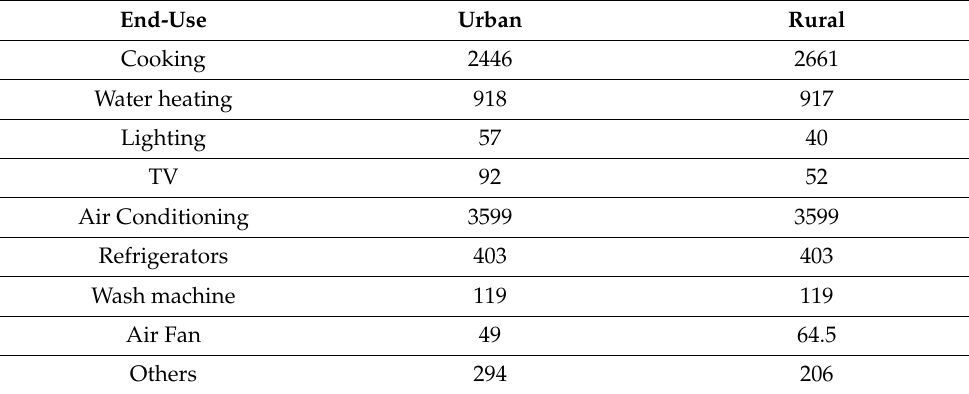
Table 5. Useful energy intensity in MJ/household